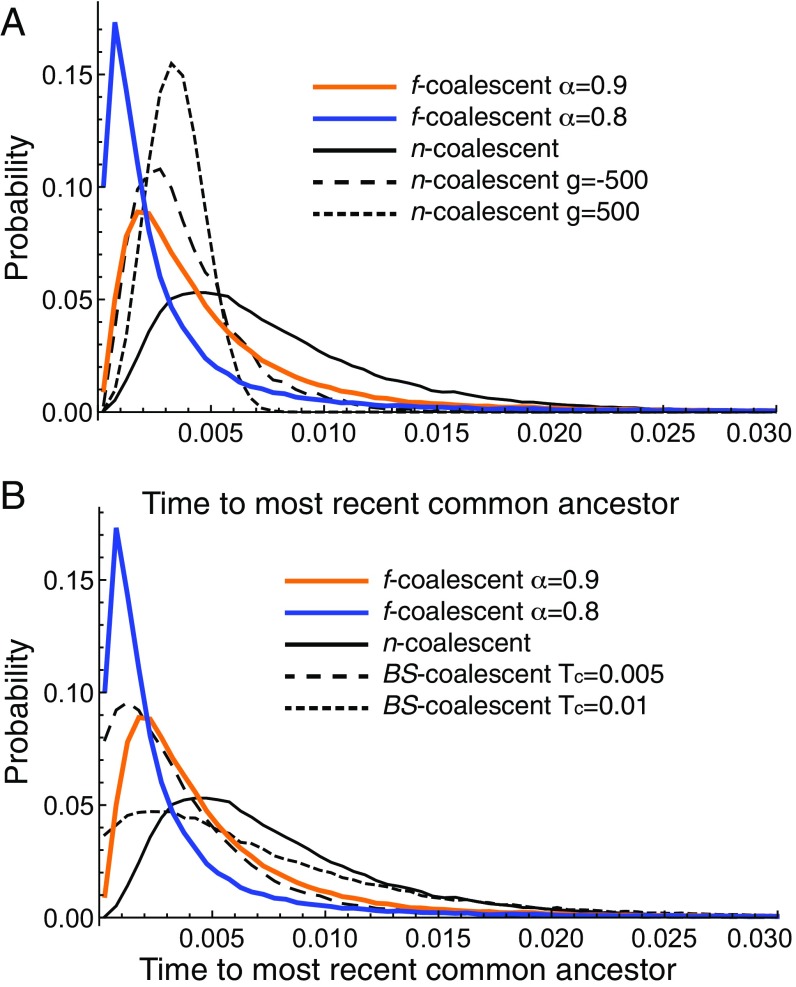
Empirical distribution of the time of the most recent common ancestor for various coalescents: strictly bifurcating (A) and f-coalescent vs. n-coalescent and multifurcating BS-coalescent (B). The x axis is truncated at 0.03. Each curve represent a histogram of 100,000 draws of the TMRCA.